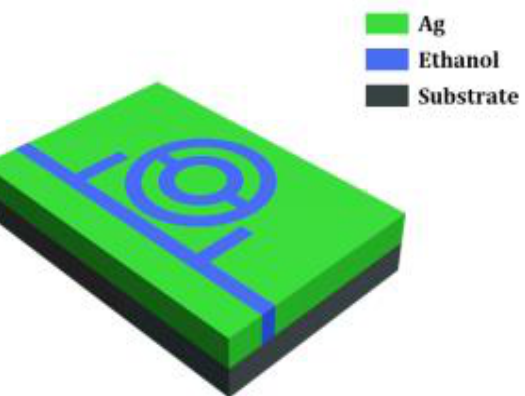
Figure 9. Three-dimensional schematic of the temperature sensor based on the MIM